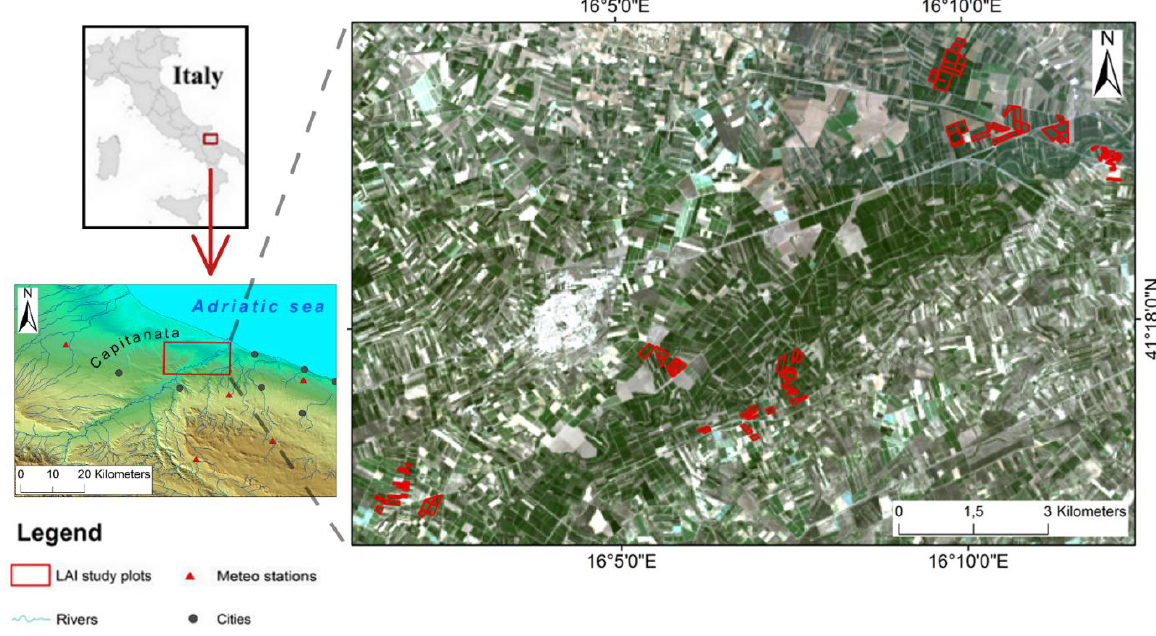
Figure 1. Study area location with overview of LAI plot measurements. Natural color composition of Landsat 8 image acquired on 26 August